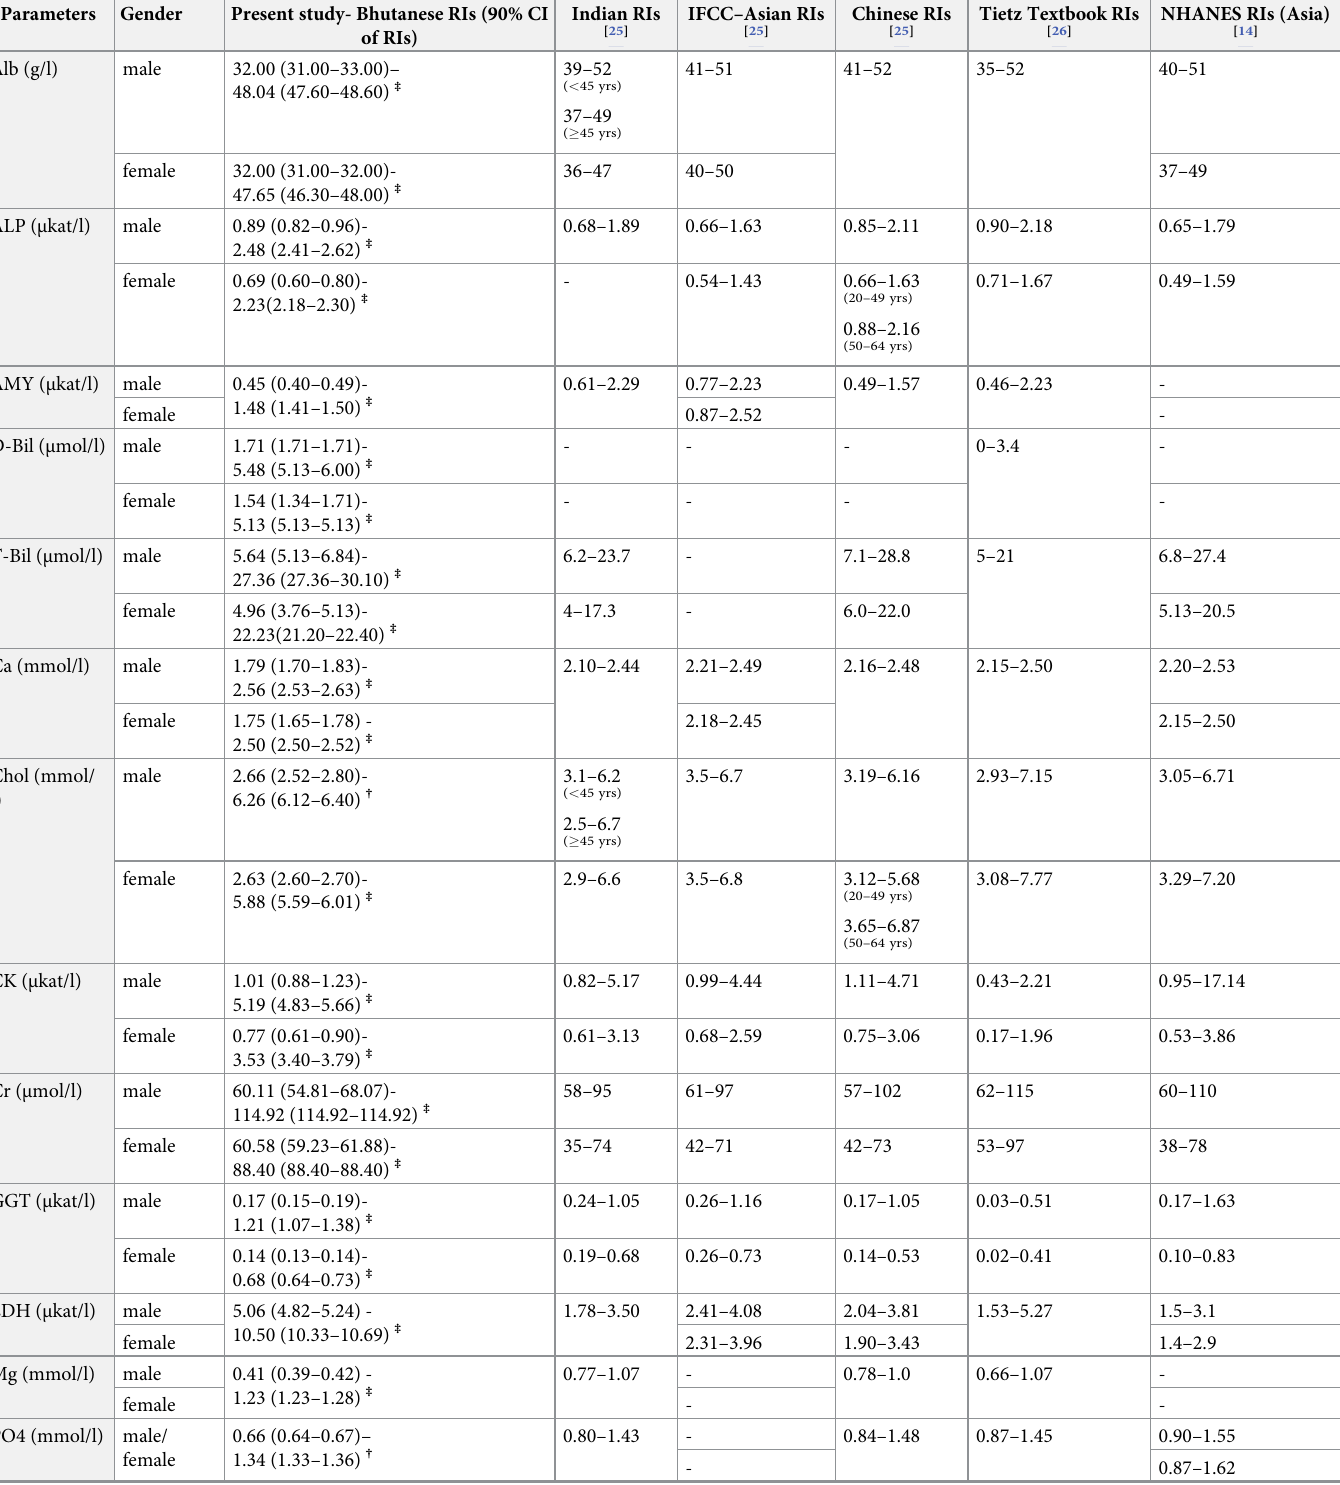
Table 5. The clinical chemistry RIs of healthy Bhutanese adults, 90% CI of the reference limits and other published clinical chemistry RIs for comparison. Parameters